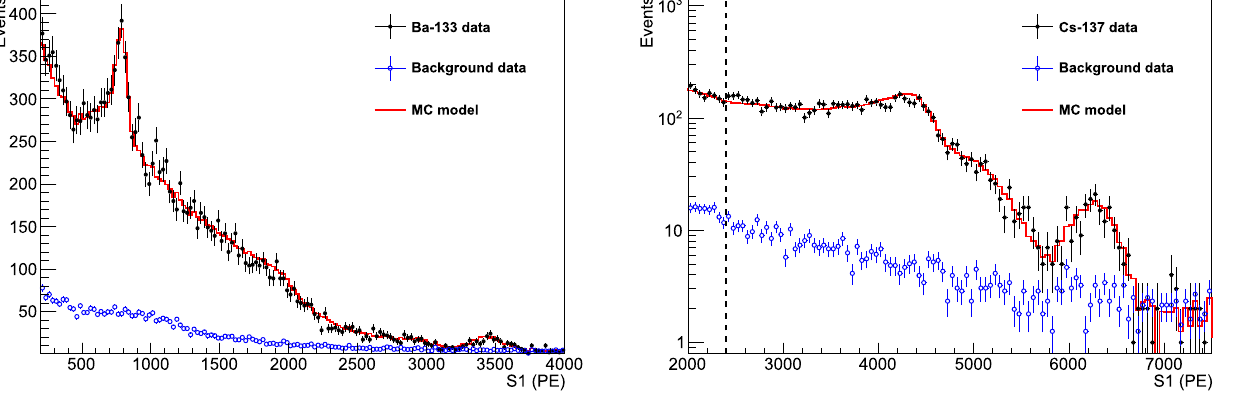
and E el set to their standard reference values of